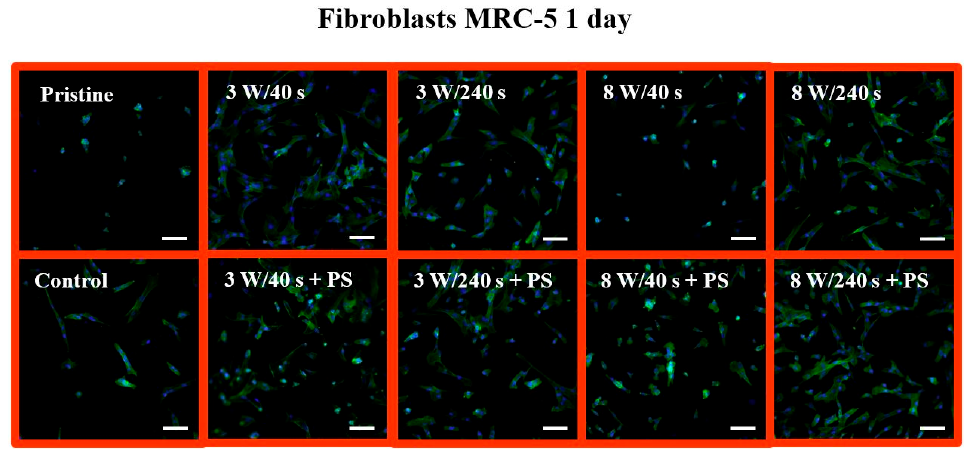
Figure 13. Fluorescence microscopy images of primary human fibroblasts (MRC-5) at 1 day post- seeding on FEP (Pristine), FEP matrices treated using plasma with 3 and 8 W (40 and 240 s) and subsequently coated with a honeycomb-like pattern formed from PS. As a control, a glass coverslip was used. Nuclei stained with DAPI are in blue, F-actin labeled with phalloidin-Atto 488 is in green. The scale bars represent 100 µm.